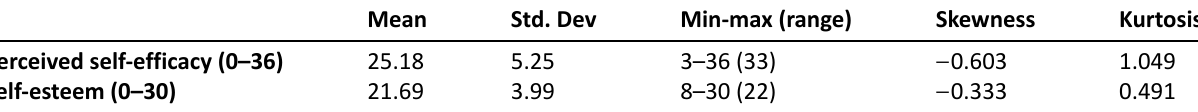
Table 2. Mean scores